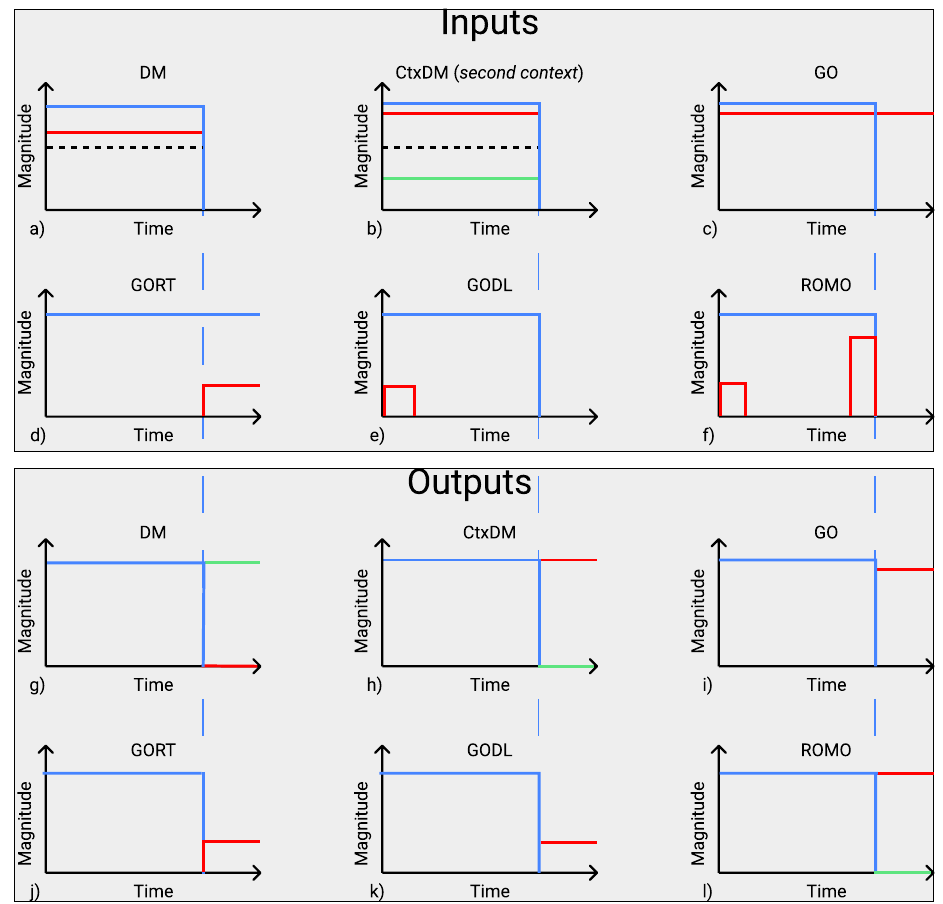
Figure 2. Target tasks used to train the spiking neural network. The top subplots ( a – f ) show the inputs, where the blue lines correspond to the fixation input u fix and the red and green lines show the input stimuli u mod 1 and u mod 2 , respectively. The bottom subplots ( g – l ) show the target outputs, where the blue lines indicate the fixation output y fix and the red and green lines show outputs y 1 and y 2 , respectively. ( a ) Decision-making ( DM ) task: if the input stimulus u 1 is higher on average than the threshold (the dotted line), then the target outputs are y 1 = 0 and y 2 = 1 ( g ). Otherwise, ( y 1 , y 2 ) = ( 1, 0 ) . ( b ) Context decision-making ( CtxDM ) task: the context signal indicates which of the stimuli u 1 or u 2 should be compared with the threshold (the dotted line). The outputs ( h ) are analogous to DM . ( c ) Inputs and ( i ) corresponding outputs of the go task ( Go ). ( d ) Inputs and ( j ) corresponding outputs of the go task with reaction times ( GoRt ). ( e ) Inputs and ( k ) corresponding outputs of the delayed go task ( GoDl ). ( f ) Working memory Romo task ( Romo ): if the second input stimulus is larger than the first one, then the target output ( l ) is ( y 1 , y 2 ) = ( 1, 0 ) ; otherwise, ( y 1 , y 2 ) = ( 0, 1 ) . The blue vertical lines show the termination of the fixation